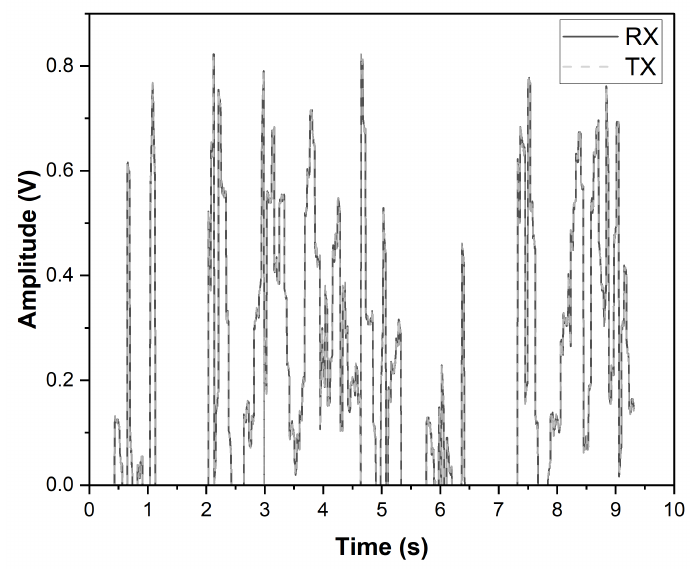
Figure 9. Comparison of the ECG signal at the transmitter and receiver. Table 4. Comparison with other nRF24L01 works at 3.3